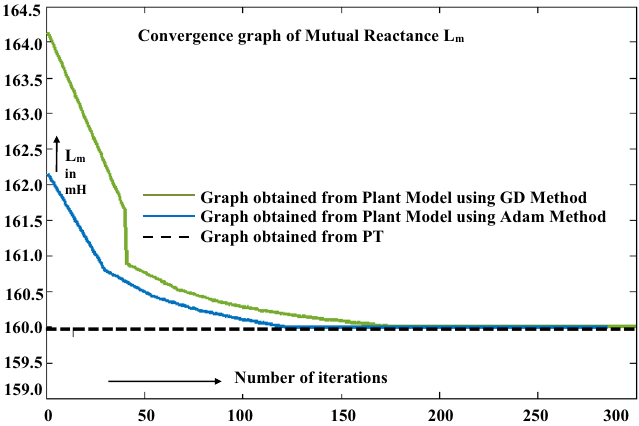
Fig. 13 Convergence of BPANN based estimation of L m with GD, ADAM methods